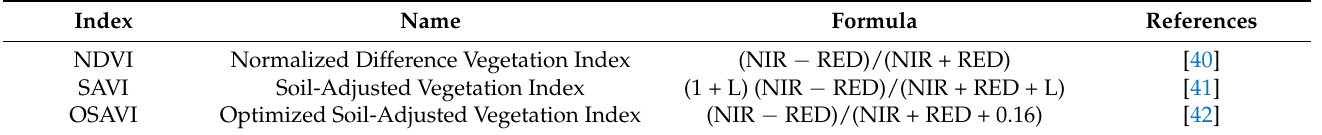
Table 1. Vegetation indices abbreviation, name, formula, and